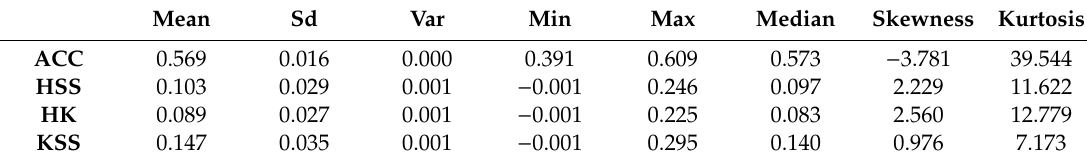
Table 8. Statistics for the scores of the Classification tree